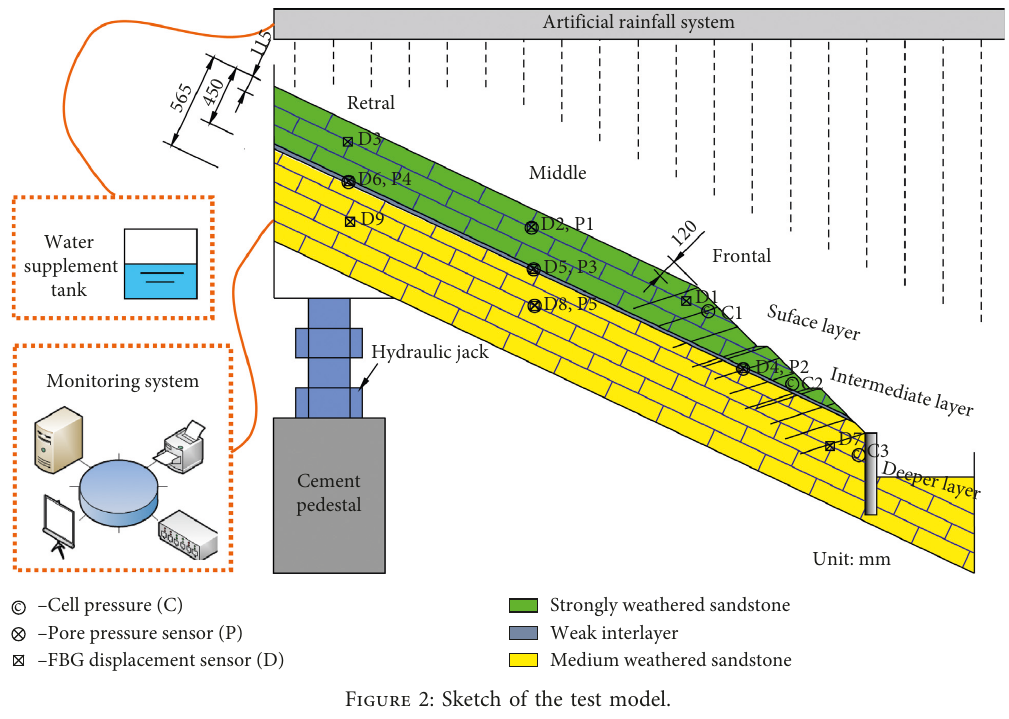
Figure 2: Sketch of the test model.